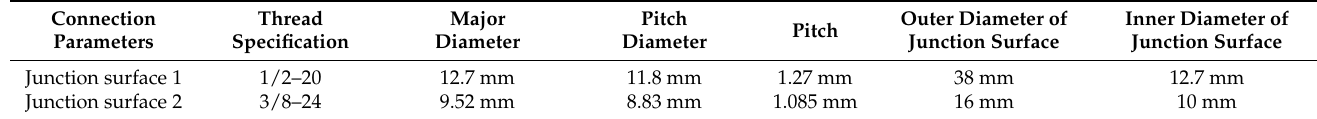
Table 1. Connection parameters of each junction surface.